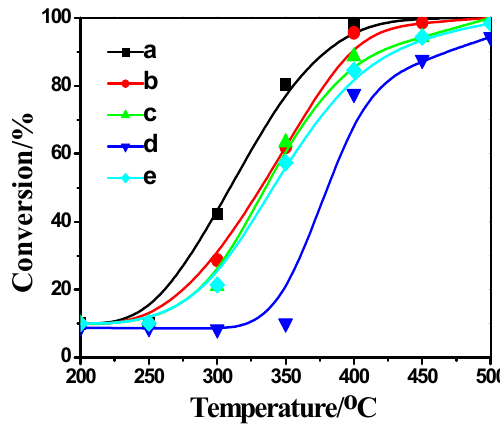
Figure 5. Activity measurement results of N 2 O direct dissociation over Mg x Co 1 − x Co 2 O 4 ( x = 0.2, 0.3, 0.4, 0.5) composite spinel metal ‐ oxide catalysts. Reaction conditions: N 2 O:He = 35:65, gas hourly space velocity (GHSV) = 30,000 h − 1 ; ( a ) Mg 0.2 Co 0.8 Co 2 O 4 ; ( b ) Mg 0.3 Co 0.7 Co 2 O 4 ; ( c ) Mg 0.4 Co 0.6 Co 2 O 4 ; ( d ) Mg 0.5 Co 0.5 Co 2 O 4 ; ( e ) Co 3 O 4 .